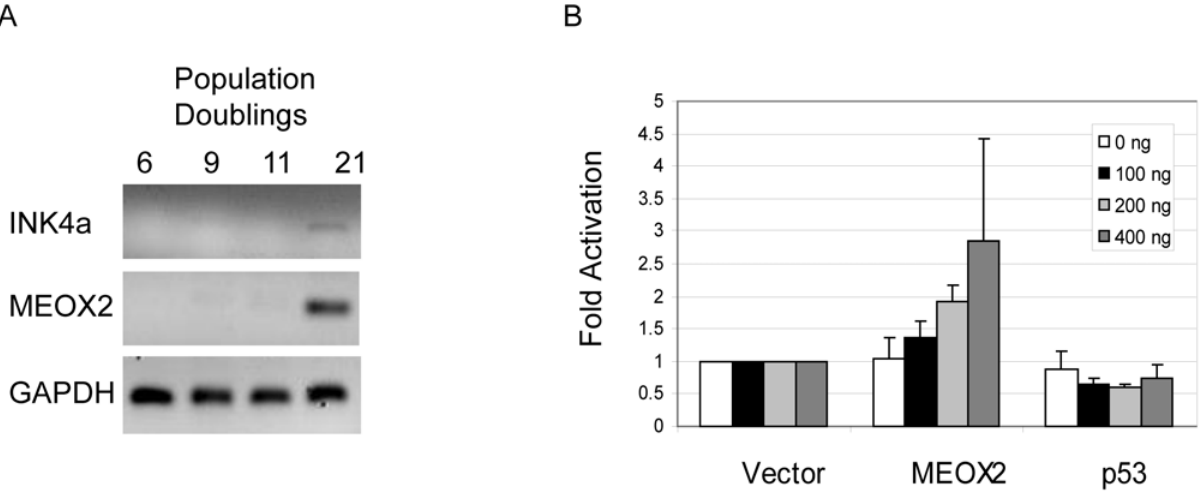
Figure 3. MEOX2 is a regulator of senescence in human cells. (A) MEOX2 is upregulated during senescence. Results of semiquantitative RT- PCR analysis on mRNA derived from primary human keratinocytes at the indicated number of population doublings are shown. (B) Dose-response for p16INK4a reporter activation by MEOX2. Results are shown from three independent cotranfections of U2OS with the indicated reporter and cDNA constructs as in Fig. 2. Error bars represent one standard deviation; p53 serves as a negative control.